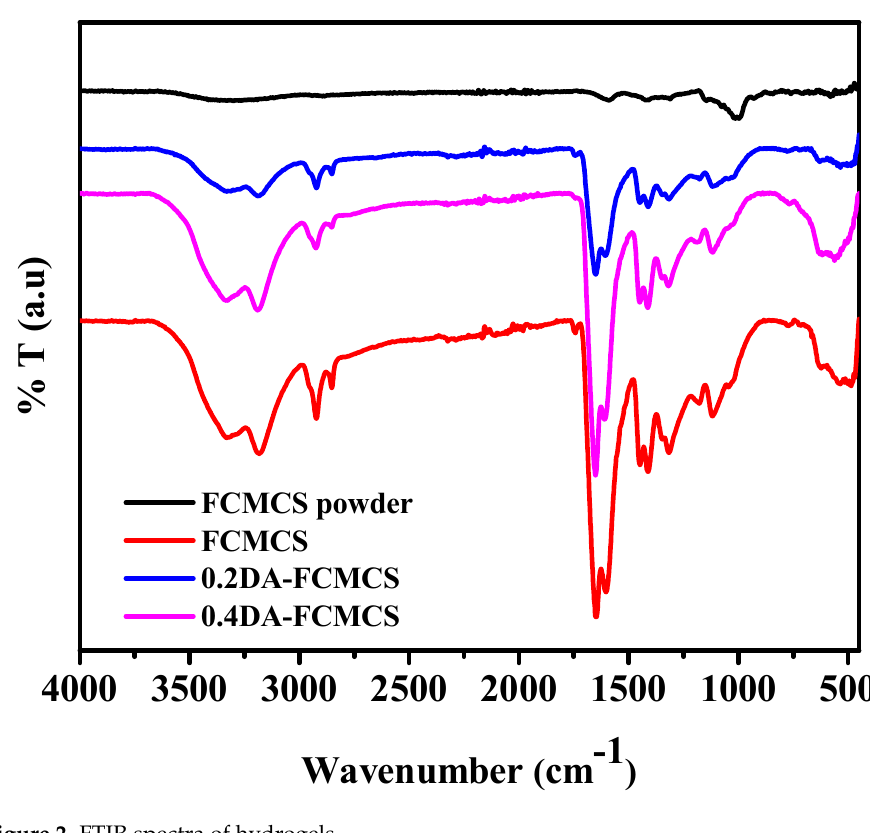
Figure 2. FTIR spectra of hydrogels. Table 1. FTIR peak assignments of hydrogels.